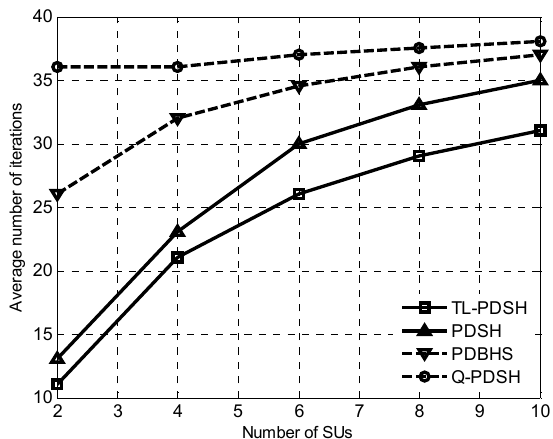
Figure 3. Average number of iterations versus number of SUs.